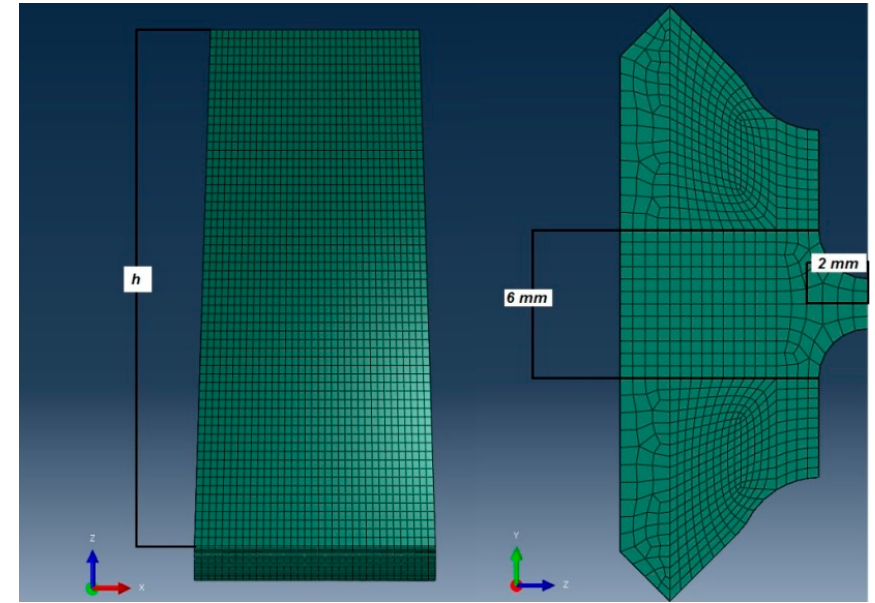
Figure 4. Airfoil length and transition area details.